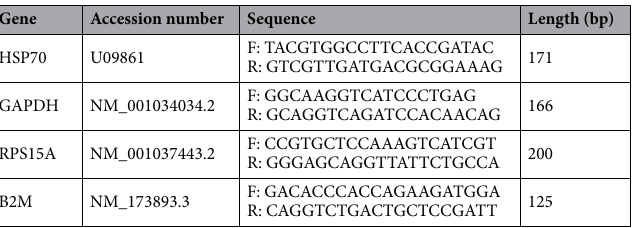
Table 4. Primer sequences, lengths, and accession numbers in bovine. HSP heat shock protein, GAPDH glyceraldehyde-3-phosphate dehydrogenase, RPS15A ribosomal protein S15a, B2M